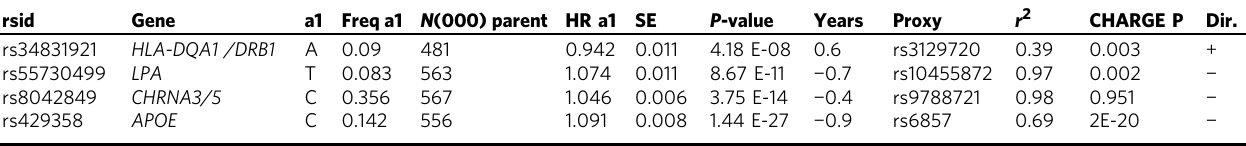
a1 the effect allele, CHARGE, CHARGE European GWAS for survivorship beyond age 90 vs. younger controls, 6 CHARGE P, the p -value for the two-sided test of association between proxy and long- livedness in CHARGE, Dir. direction of effect of a1 in CHARGE: “ + ” means long-livedness increasing, “ − “ means long-livedness decreasing, Freq. frequency, N (000) count (thousands of parents with lifespan and subject genotype information), HR, Hazard Ratio, P p -value for the Wald test of association between imputed dosage for a1 and lifespan, Proxy, the closest proxy SNP in CHARGE, r 2 the linkagedisequilibrium betweenthe discovery SNPand its CHARGEproxy, inthe 1000genomes EUpanel,SE, Standard Error, Yearsthe number of additionalyearsof lifespanexpected fora carrier of one additional copy of a1. There are four overlapping cohorts between the two studies; EGCUT, NTR, PROSPER and RS1, but only RS1 contributed cases to the CHARGE: out of all 5406 cases analysed in CHARGE, 892 cases (from RS1) overlapped the 300,000 genotyped subjects studied in discovery and the phenotyped individuals were in any case not the